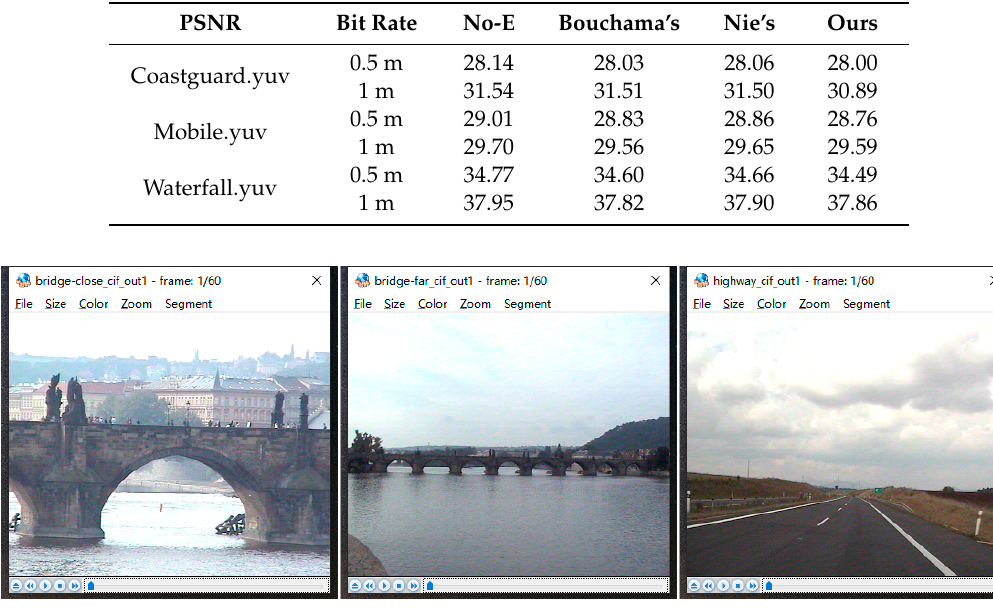
Figure 3. Original video frame.